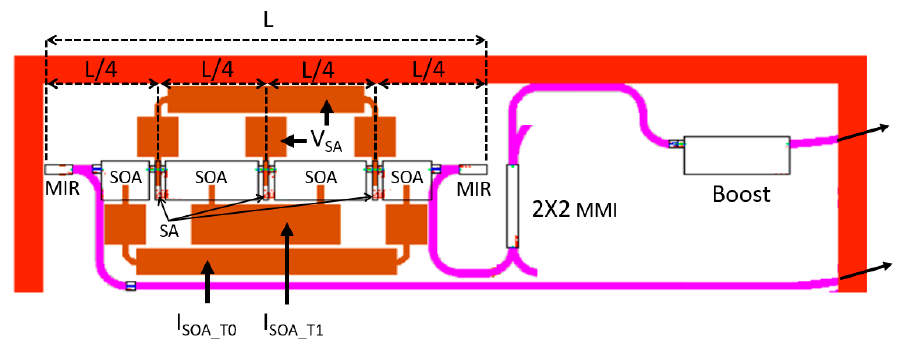
Figure 7. Schematic layout of multiple colliding pulse MLL. The Fabry-Pérot cavity with length L ~ 1.66 mm is defined by two MIRs, having four gain sections (SOAs) separated by three SAs that divide the cavity in four, L/4 ~ 0.42 mm. The electrical connections for the active components are achieved by routing of DC pads ( brown ). The passive waveguides ( pink ) route the light to the outputs at chip facets.